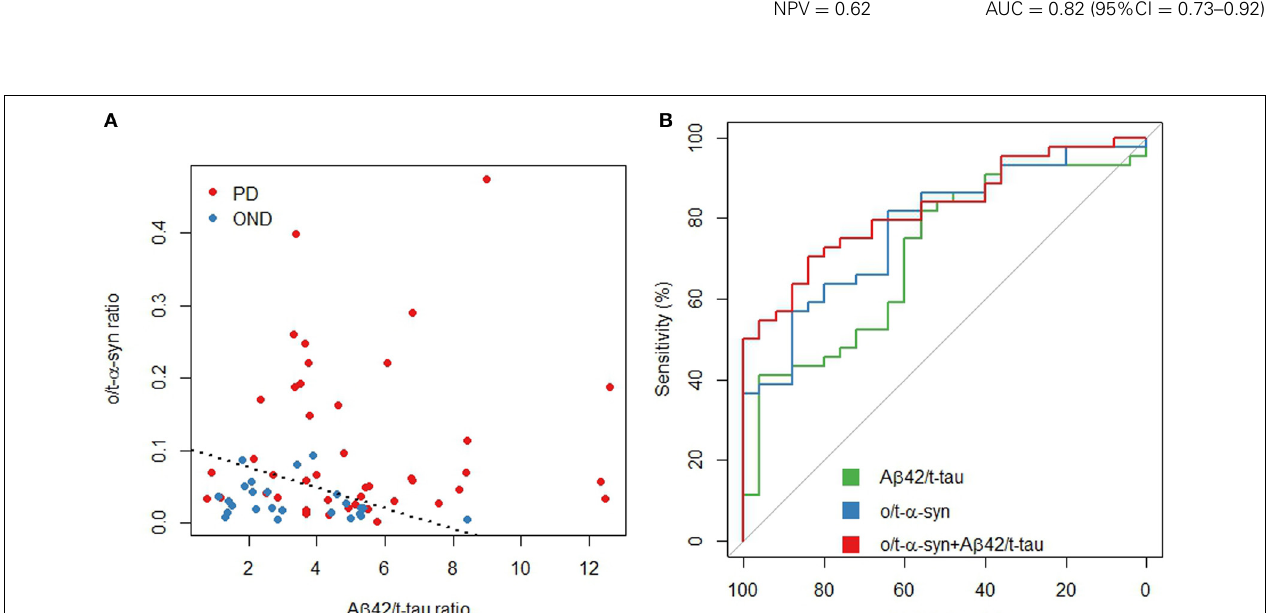
above the line the model predicts PD (B) ROC curves of A β 42 /t-tau and o/t- α syn ratios and the fitted values of the multivariable logistic regression